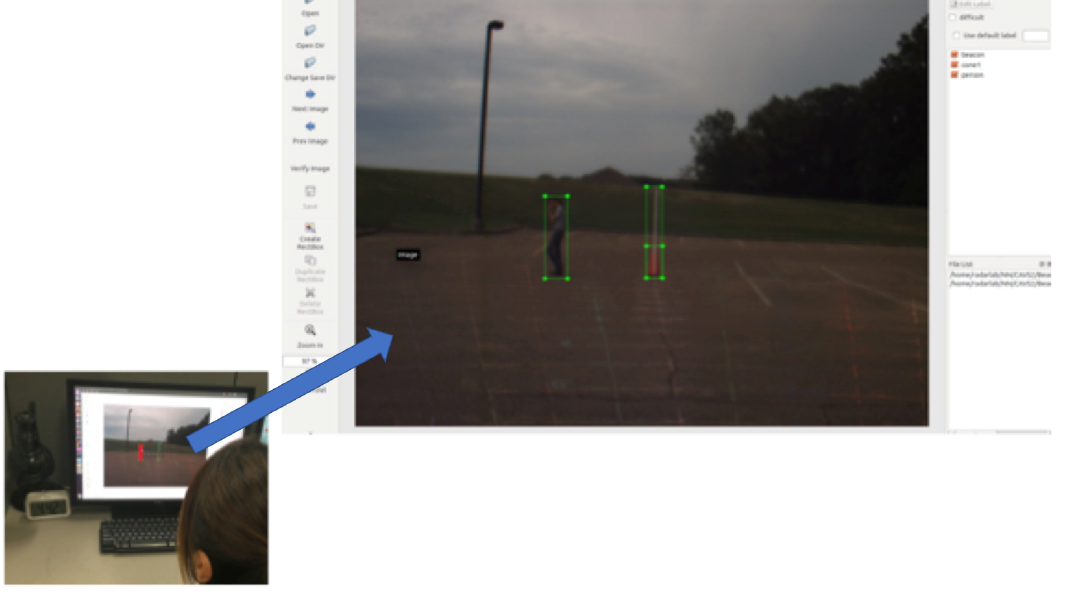
Figure 6. Labeling for camera detection.